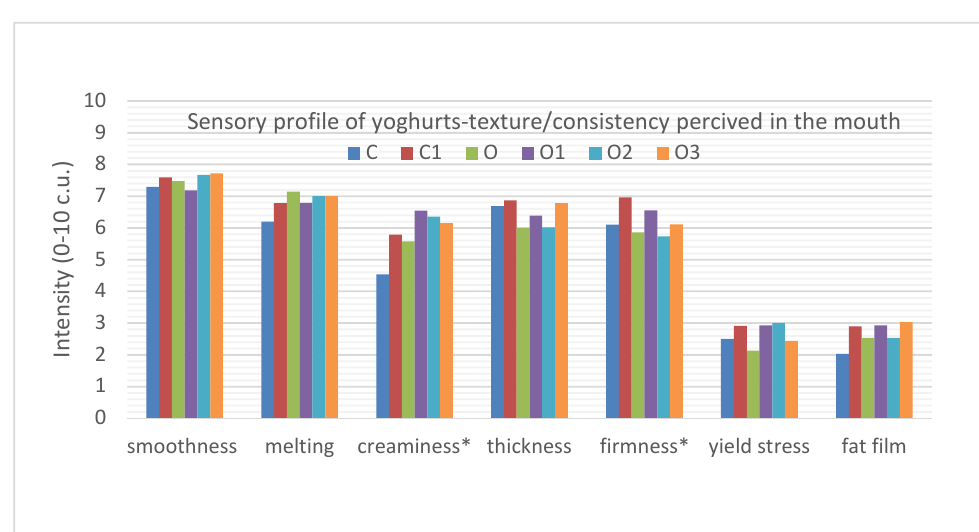
Figure 3. Sensory quality profile of yoghurts describing the texture/consistency attributes perceived in the mouth. C, control; C1, control with 6% inulin; O, oolong tea; O1, oolong tea with 3% inulin; O2, oolong tea with 6% inulin; O3, oolong tea with 9% inulin (* p ≤ 0.05 differ significantly).